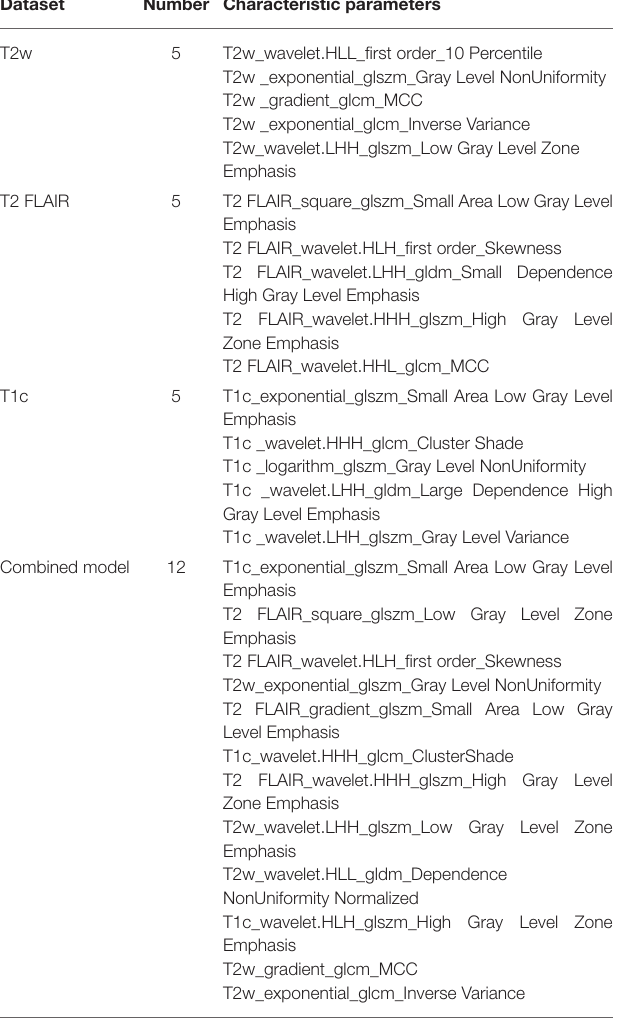
TABLE 3 | Best characteristic parameters of the four models.